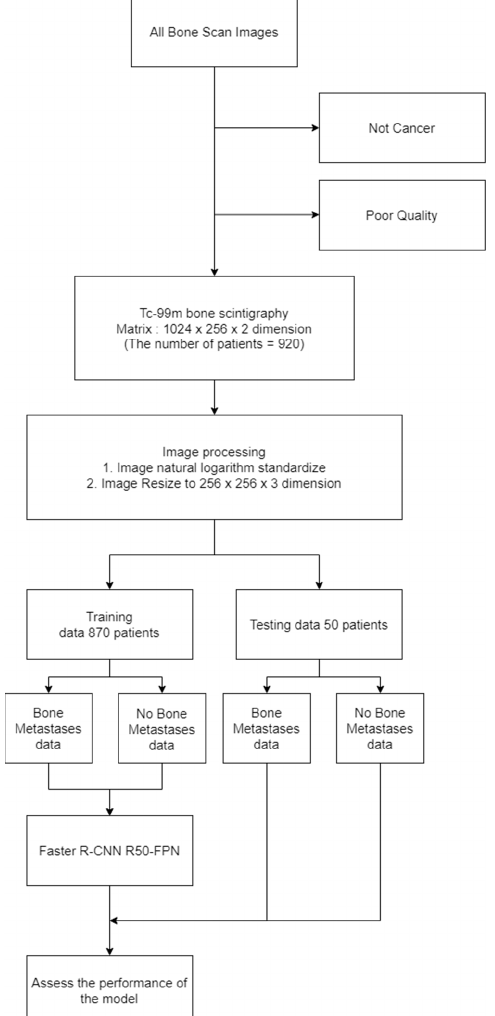
Figure 2. Flowchart for this study.